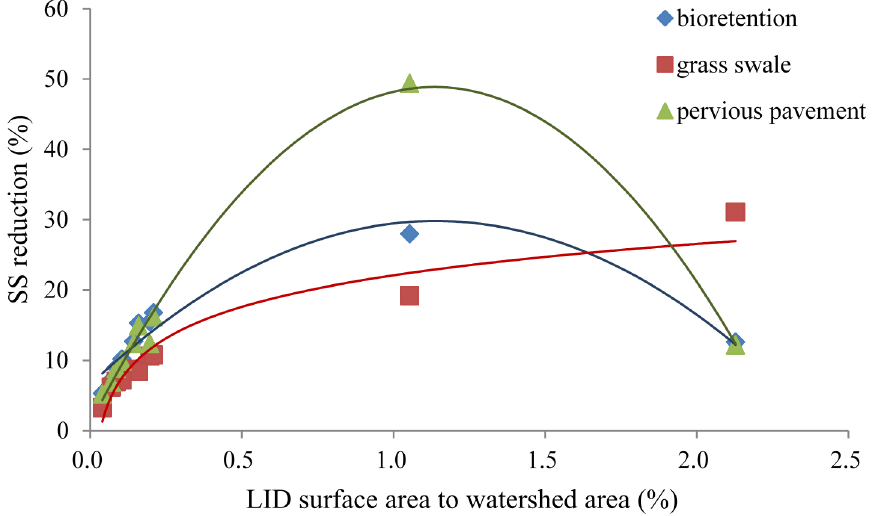
Figure 7. Effects of LID area as a percentage of watershed area on pollution reduction, as measured by SS reduction. Optimal LID surface area is 1% of watershed area, regardless of LID